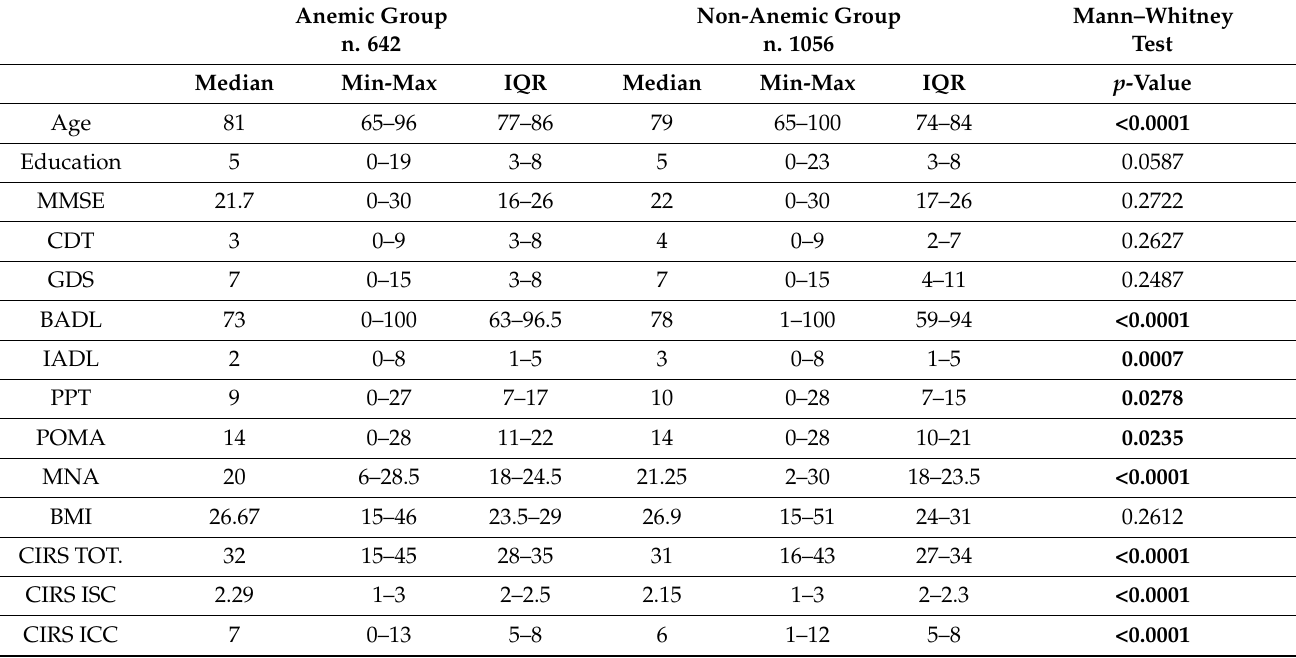
Table 4. Anemic group vs. non-anemic group (WHO